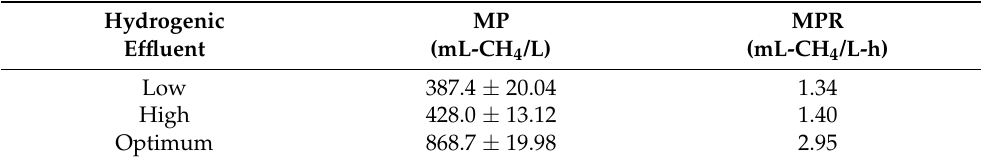
Figure 4. Time course profile of methane production from the hydrogenic effluent of crude glycerol codigested with algal biomass at the initial pH of 7.5 at low (10 g/L of glycerol, 6.17% of inoculum, and 4.62 g-VS/L of algal biomass), high (40 g/L of glycerol, 25% of inoculum, and 23.1 g-VS/L of algal biomass), and optimal (13.83 g/L of glycerol, 10.31% of inoculum, and 23.1 g-VS/L of algal biomass) conditions. Table 5. MP and MPR using the hydrogenic effluent as substrates from low, high, and optimal